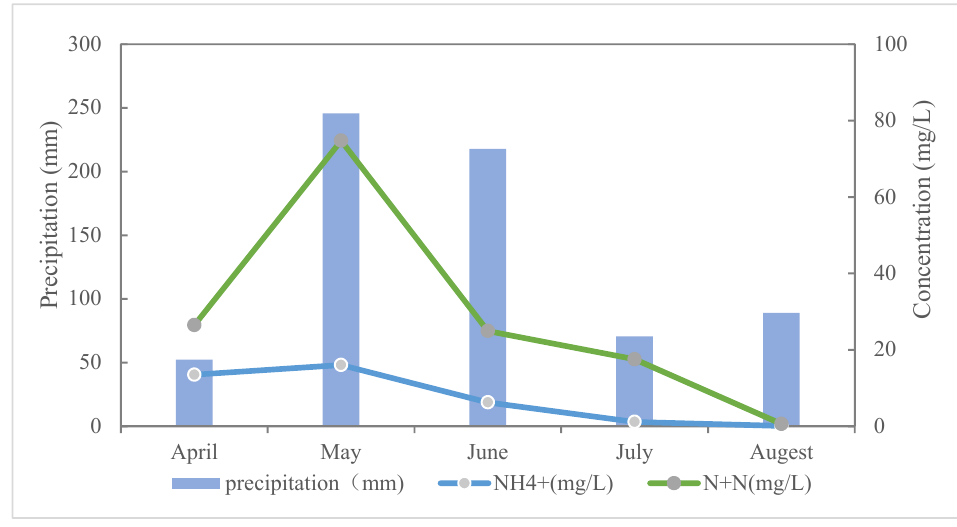
Figure 7. Trends of precipitation and ionic inorganic nitrogen.